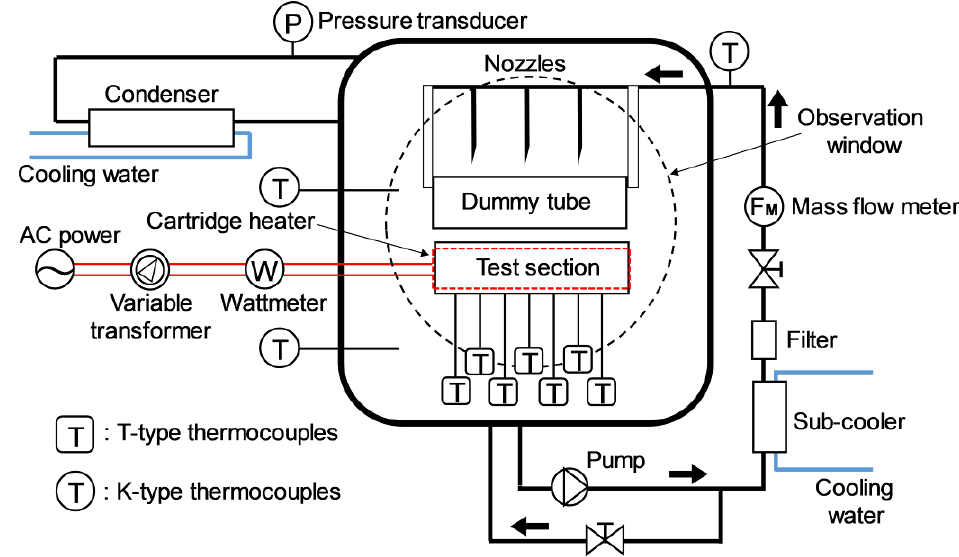
Figure 1. Schematic of the experimental apparatus.